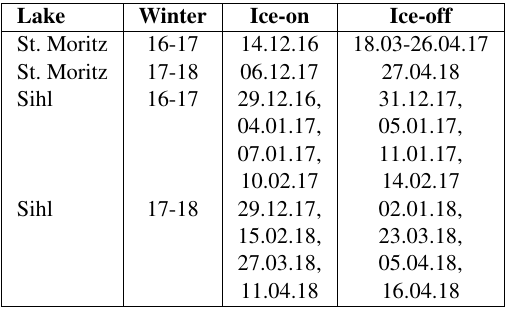
Table 4: Ice-on/off dates predicted by our approach. Lake